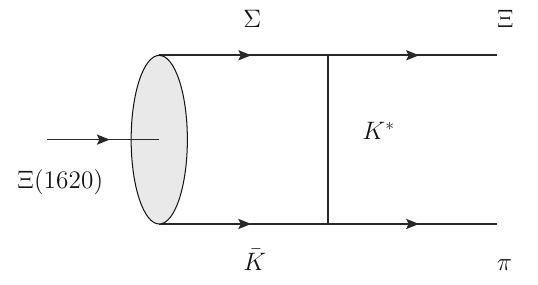
Fig. 3 Diagram contributing to the (cid:2)( 1620 ) → (cid:2) − π +